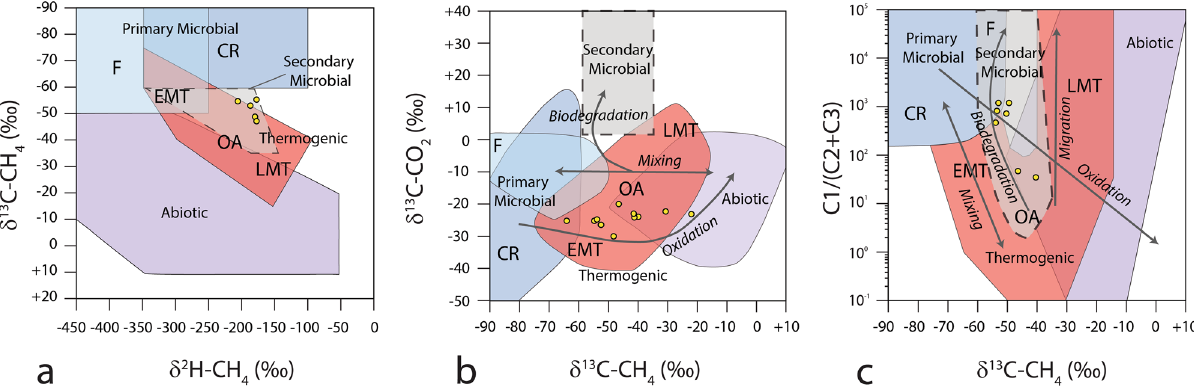
Figure 4. ( a ) Stable carbon (δ 13 C) and hydrogen (δ 2 H) isotope composition of methane from headspace gas analysis. Samples are reported in yellow dots. Genetic fields (CR -CO 2 reduction, F—methyl-type fermentation, EMT—early mature thermogenic gas, OA—oil-associated thermogenic gas, LMT—late mature thermogenic gas) after Milkov and Etiope 59 . ( b ) Genetic diagrams of δ 13 C-C1 versus δ 13 C-CO 2 . Grey arrows indicate the main processes that affect the carbon isotopic composition of methane and CO 2 in natural gases 59 . ( c ) Plot of δ 13 C-C1 versus the composition of light hydrocarbon components (C1/(C2 + C3) ratio). Grey arrows indicate the main processes affecting δ 13 C-C1 and the molecular composition of gases 59